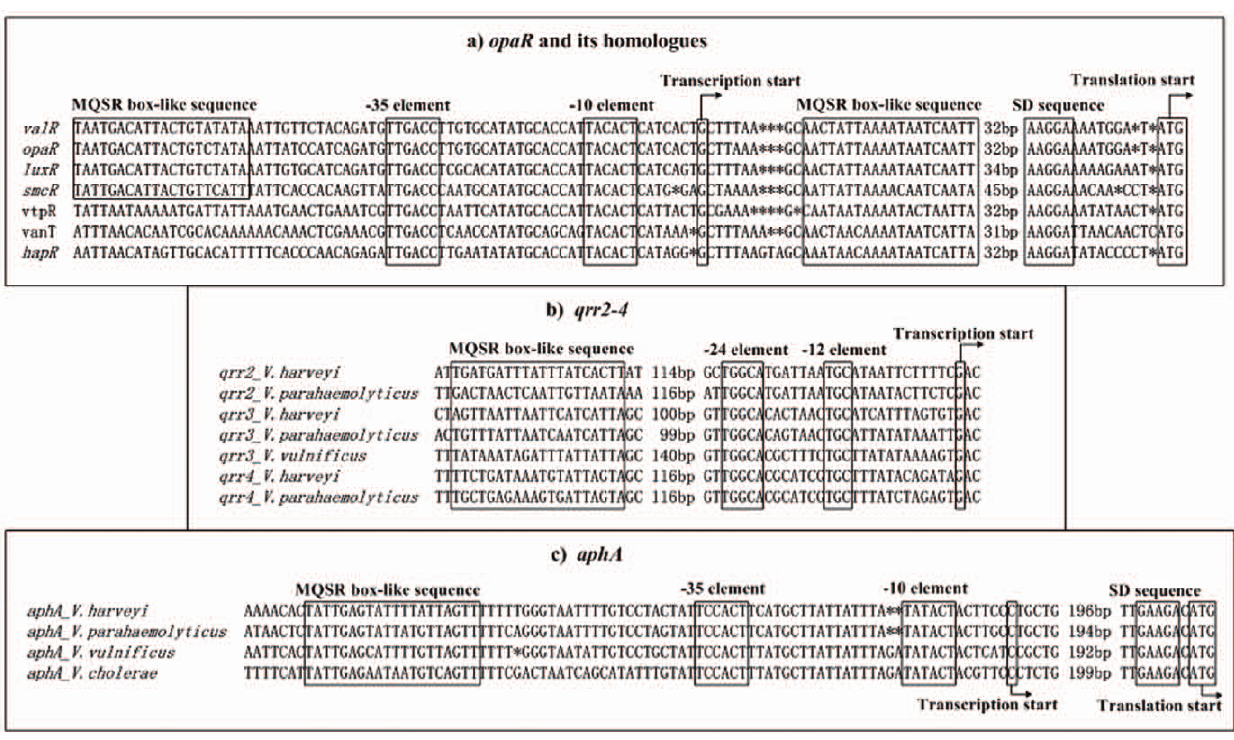
Figure 8. Organization of promoter DNA regions. DNA sequences were derived from V. alginolyticus ZJ-51 [60], V. parahaemolyticus RIMD 2210633 [16], V. harveyi ATCC BAA-1116 [61], V. vulnificus YJ016 [62], V. tubiashii RE22 [63], V. anguillarum 775 [64], V. cholera N16961 [65], and V. fischeri MJ11 [66]. Shown were translation and transcription starts, SD sequences, MQSR box-like sequences, and 2 10/ 2 12 and 2 35/ 2 24 core promoter